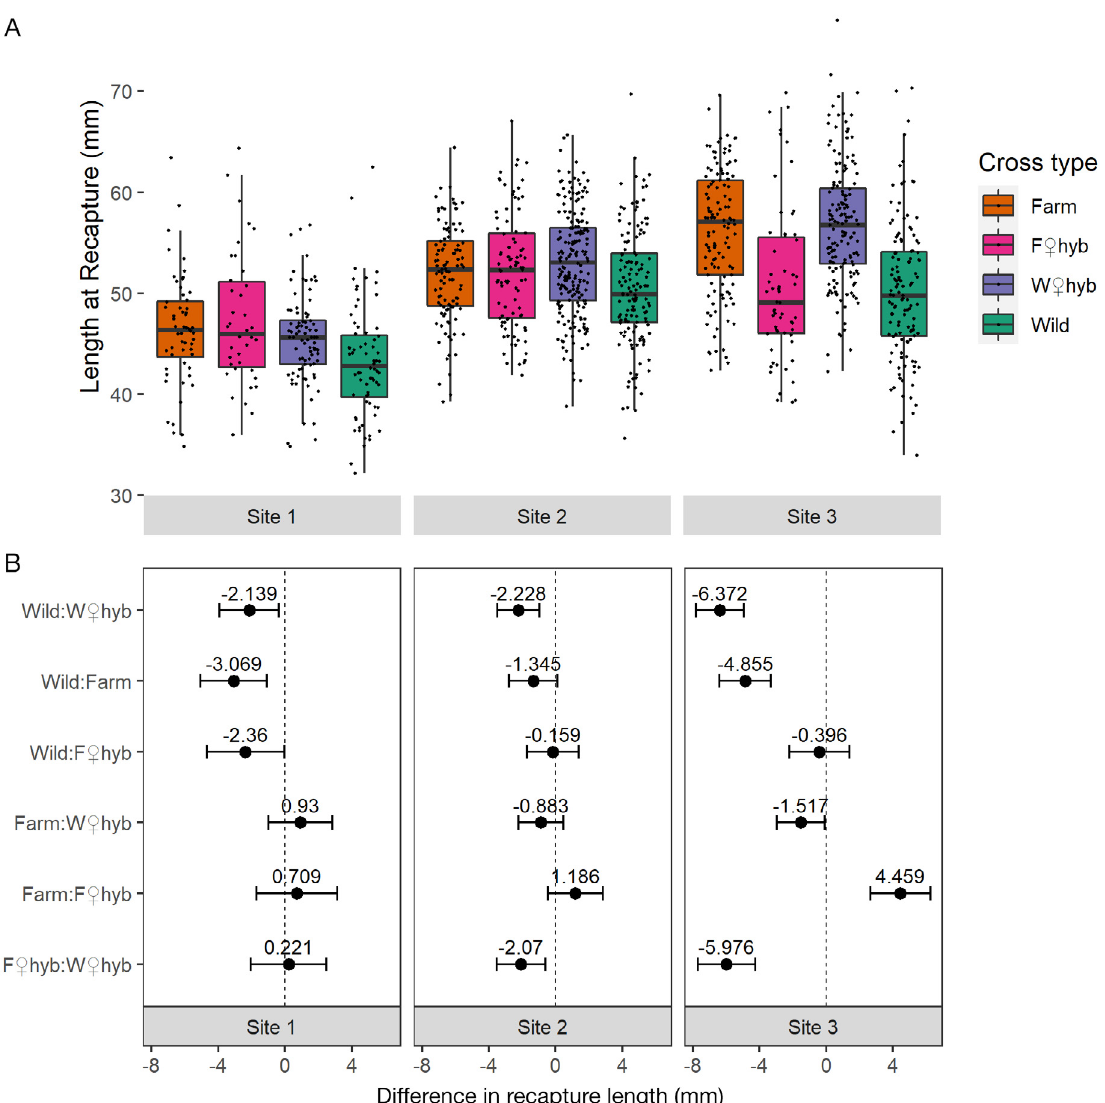
Fig. 6. Same as Fig. 5, but for (A) lengths of each Atlantic salmon at recapture for each cross type by site pairing, and (B) pairwise differences in mean recapture length for each cross type by site For pectoral fin length, after accounting for the = 483.4, LR = 7.04 effect of fish standard length ( F 1,96 × 10 35 , p < 0.001), there was strong evidence for an = 19.5, LR = 2.19 × 10 6 , effect of site on this trait ( F 2,96 p < 0.001), but insufficient evidence for an effect of cross type or any interactions (LR < 1, p > 0.1). Pre- dicted pectoral fin lengths were back-calculated from ln-transformed emmeans predictions: 11.59 mm (Site 2), 10.48 mm (Site 3), and 10.38 mm (Site 1). All site predictions were calculated at the grand mean fish standard length of 43.8 mm (which was also back-calculated from the ln-transformed mean out- put by the model).